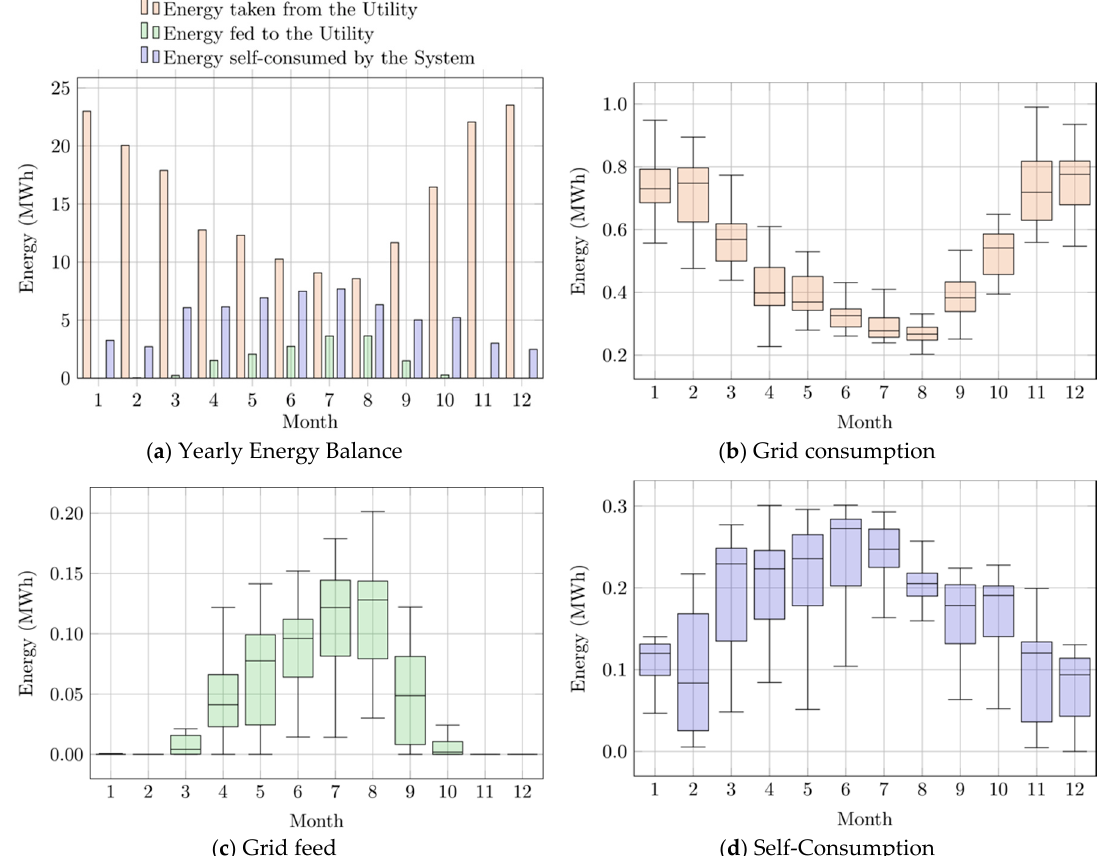
Figure 5. Energy balance of the system based on data measured during 2017. In sub-figure ( a ) the monthly energy flows of the system are reported for each month, by specifying the amount of energy absorbed from the grid, injected into the grid, and self-consumed by the system (i.e., produced by the photovoltaic system and consumed by the user’s loads). In sub-figures ( b ), ( c ), and ( d ), the interquartile analyses of the daily energy absorbed from the grid, injected into the grid, and self-consumed by the system are reported for each month, respectively.